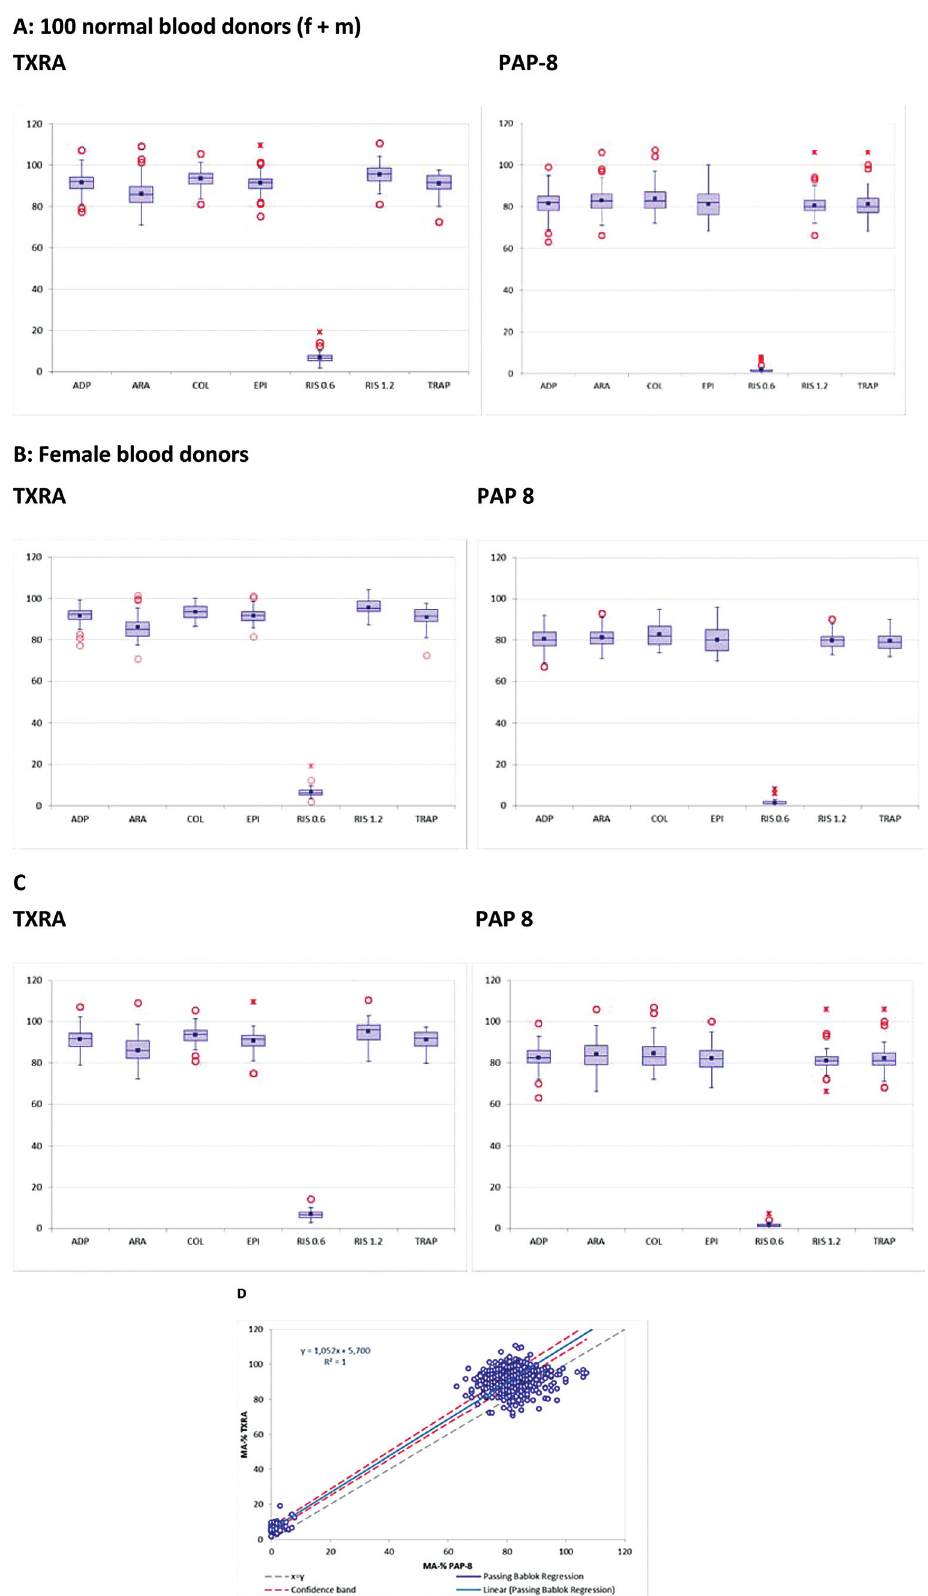
Fig. 1 Maximum aggregation (MA%) of normal blood donors. ( A – C ) Distribution of MA% values obtained in ( A ) 100 healthy blood donors, separated in ( B ) n ¼ 50 females and ( C ) n ¼ 50 males onTXRA with PPP as a reference. Box-and-whisker diagrams show minimum, lower quartile, median, upper quartile, and maximum values. Outliers are indicated by circles. Crosses indicate data points outside the 2SD-range, ( D ) method comparison (Passing – Bablok analysis) for MA% values between TXRA and PAP-8 of 100 healthy blood donors (50 f/ 50 m).